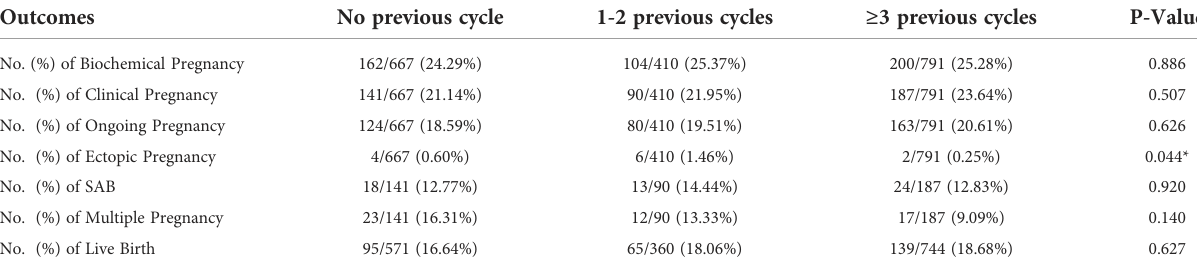
TABLE 3 Pregnancy outcomes of PCOS patients with different attempts of OI. Outcomes